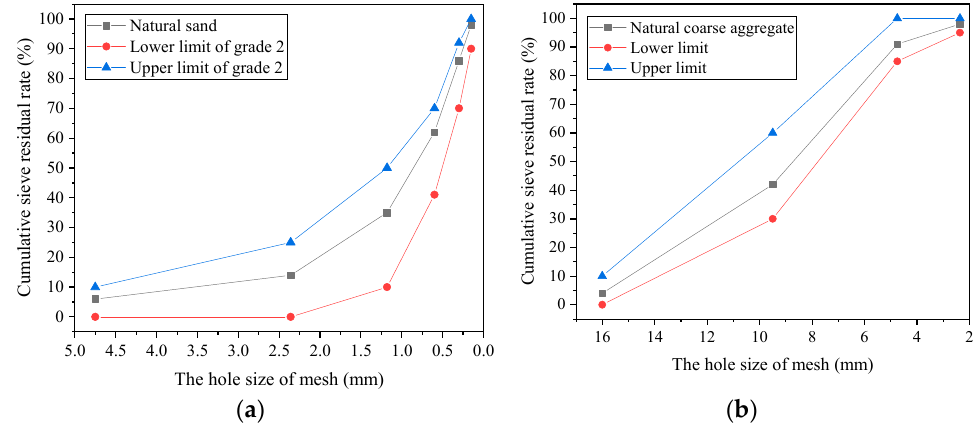
Figure 2. Gradation curve of aggregates: ( a ) natural sand; ( b ) natural coarse aggregate .